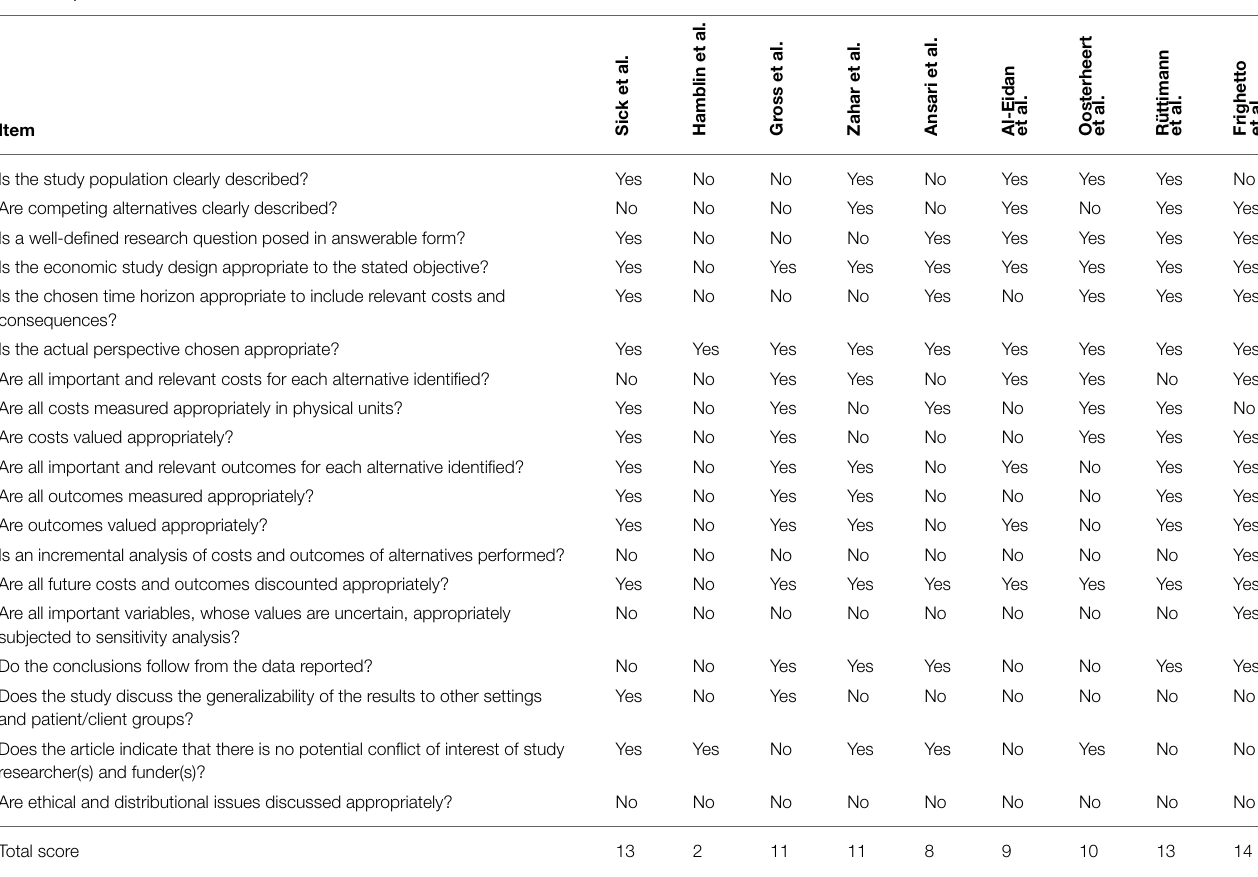
TABLE 5 | Results of CHEC list